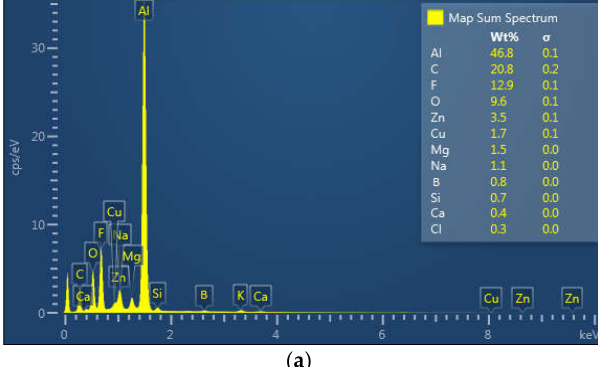
Figure 7. FE-SEM micrograph of Al359/Si 3 N 4 /Eggshell surface composites. ( a ) stir zone location 1